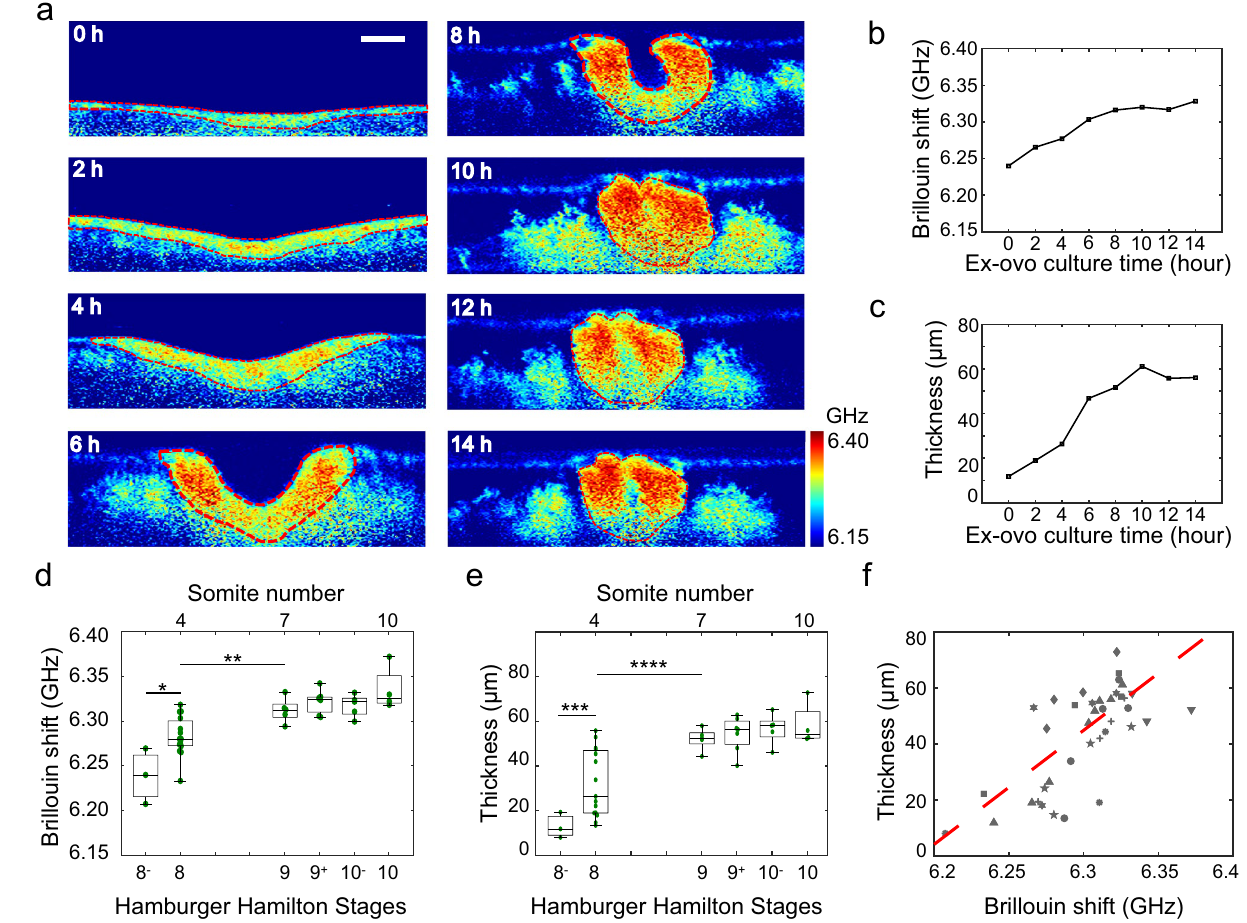
Figure 3. Time-lapse Brillouin imaging of ex ovo cultured embryos. ( a ) Time-lapse Brillouin images of a representative embryo for 14 h. ( b ) Average Brillouin shift of neural plate tissue of the embryo in ( a ) is increasing with culturing time. ( c ) Thickness of neural plate tissue of the embryo in ( a ) is increasing with culturing time. ( d ) Increase in Brillouin shift against developmental stage is observed for all the embryos (N = 9). ( e ) Tissue thickening against developmental stage is observed for all the embryos. ( f ) Correlation between the average Brillouin shift and the thickness of neural plate tissue. Symbols represent different embryos. Number of measurements: 39. Two-sample t test is used to quantify the statistical significance. * p = 0.008; ** p = 0.012; *** p = 0.049; **** p = 0.01. Scale bar is 50